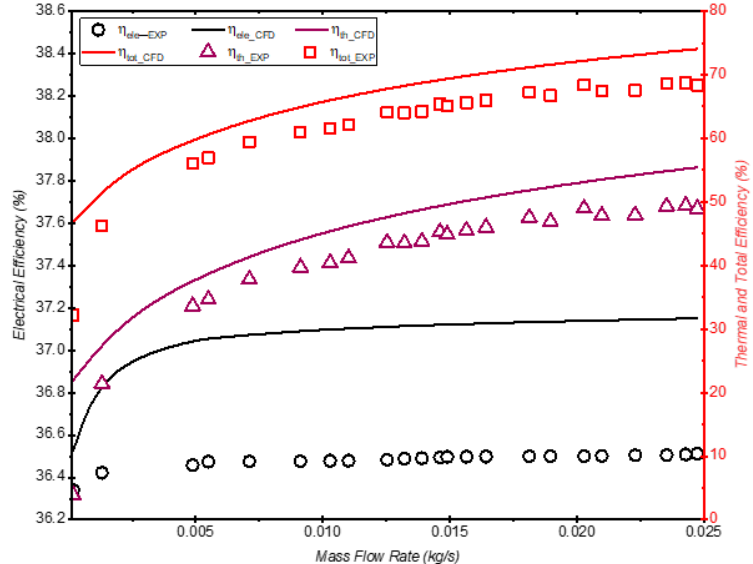
Figure 12. Comparison of thermal, electrical, and total efficiency at different mass flow rates.